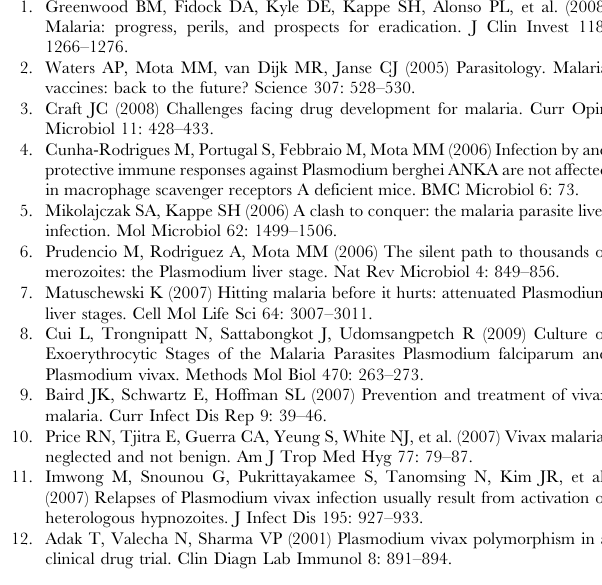
Supplementary Figure S3 Imaging of whole bodies and dissected livers (IVIS100) of mice at 44 h after infection by at both sides. Numbers in the pictures of Panel A show the number of luminescent spots identified. Supplementary Figure S4 A. Whole body imaging (IVIS100) of two representative mice during the period of 24–68 h after infection by bites of 20 infected mosquitoes, showing a strong increase of luminescence intensity of the liver during the period of 30–44 h after infection and a subsequent decrease after 52 h in the liver. The strong increase in luminescence of the whole body at 68 h is the result of the dissemination of the liver merozoites released into the bloodstream and subsequent invasion of erythrocytes. Rainbow images show the relative level of lumines- cence ranging from low (blue), to medium (green), to high (yellow/ red). B. Imaging of whole bodies and extracted livers (IVIS100) of Wistar rats at 44 h after infection by bites of 1 or 5 infected mosquitoes. Extracted livers were measured at both sides (a, b) and